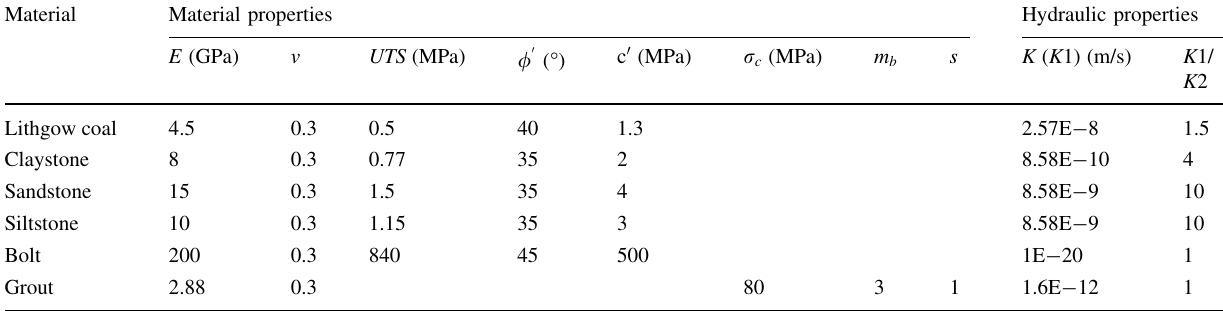
Table 1 Material and hydraulic properties used in models (Adapted from Adhikary and Wilkins (2012)) Material Material properties